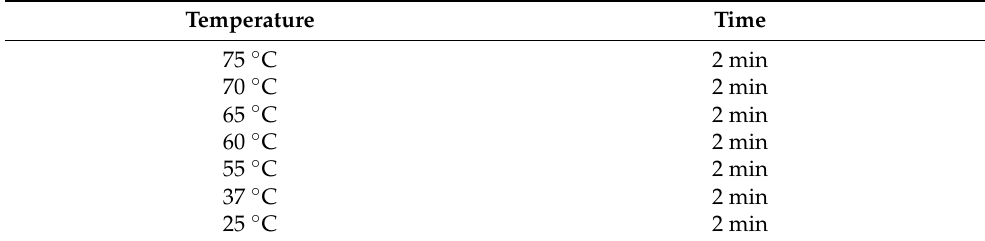
Table 4. FastSelect hybridization protocol.